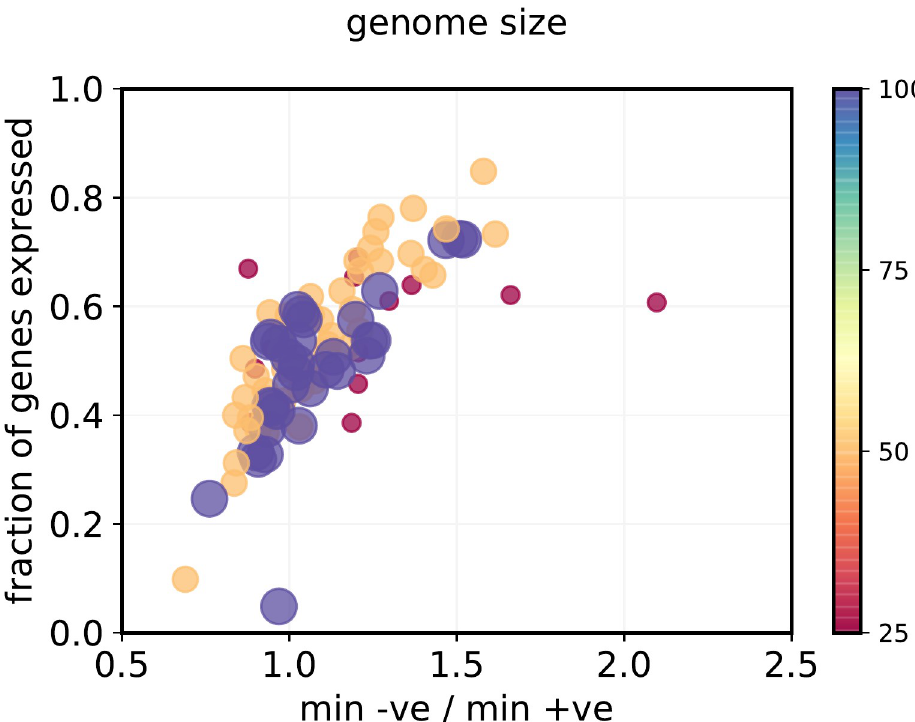
Fig 7. Relationship between the ratio of minimum negative elements to minimum positive elements (X axis: < 1 = ‘default off’) to the fraction of genes in a genome expressed at fitness plateau (Y axis). Both circle area and color scale are proportional to genome size (25, 50 or 100 genes). “Min–ve” = average length of the shortest negative regulatory element in each gene, averaged over all genes. “min +ve”= average length of the shortest positive regulatory element in each gene, averaged over all